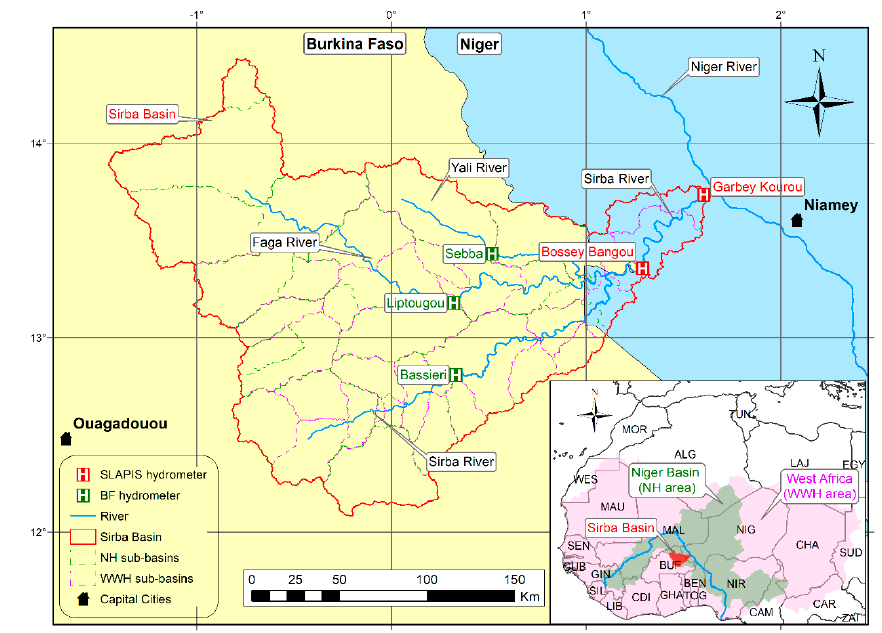
Figure 1. Geographical framework of the study area: the Sirba River Basin with the hydrometers, the main hydrographic network, the administrative boundaries, and the sub-basins of NH (Niger HYPE) and WWH (World-Wide HYPE) models. Bottom right: West Africa overview with NH and WWH covered surface.